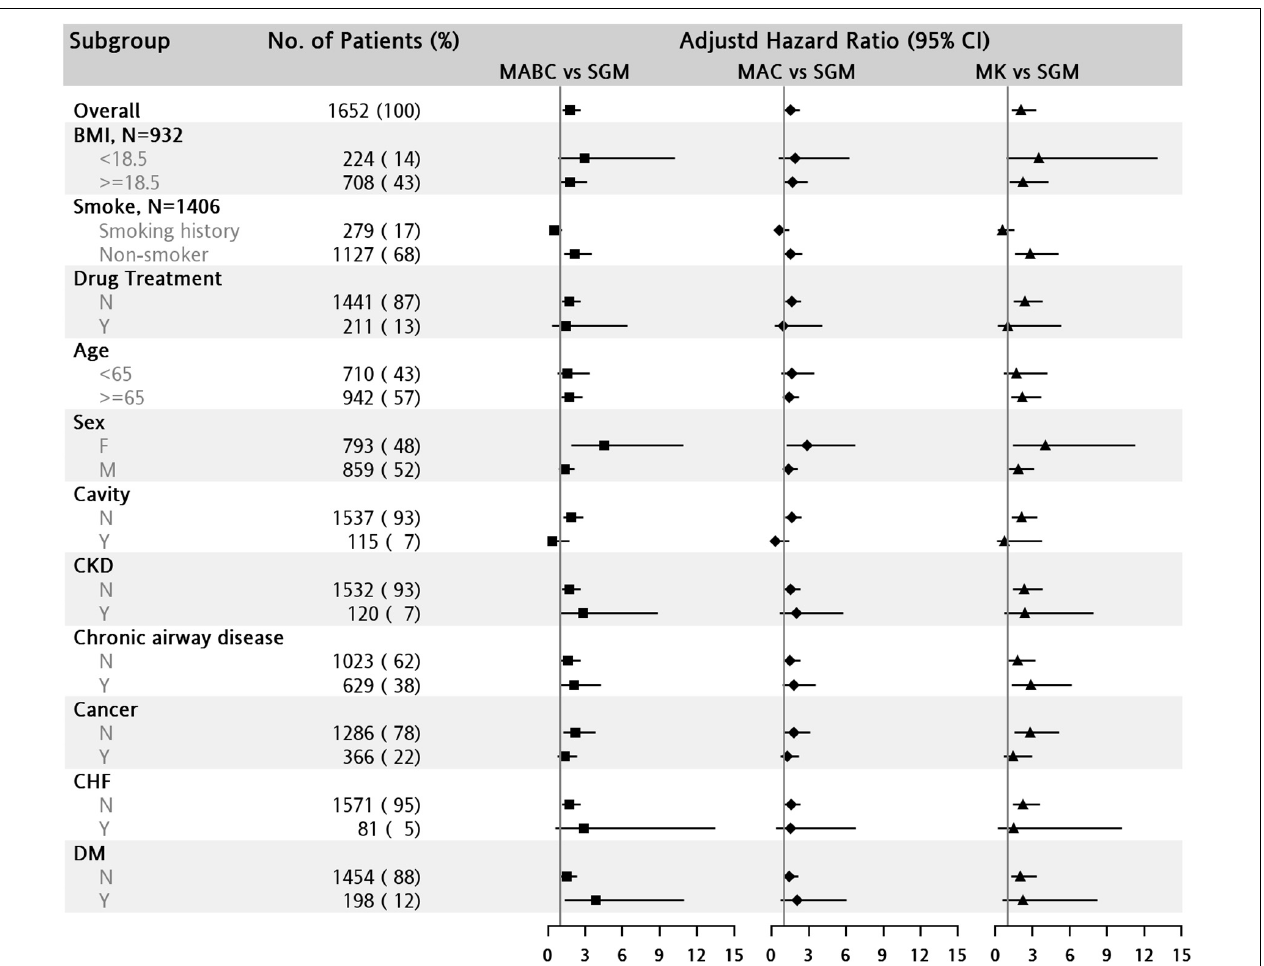
FIGURE 2 | Subgroup analysis of hazard ratio for all-cause mortality in patients with nontuberculous mycobacterial lung disease (NTM-LD). The reference group is the slow-growing mycobacteria (SGM) group. BMI, body mass index; CHF, congestive heart failure; CKD, chronic kidney disease; DM, diabetes mellitus; MABC, Mycobacterium abscessus complex; MAC, Mycobacterium avium complex; MK, Mycobacterium